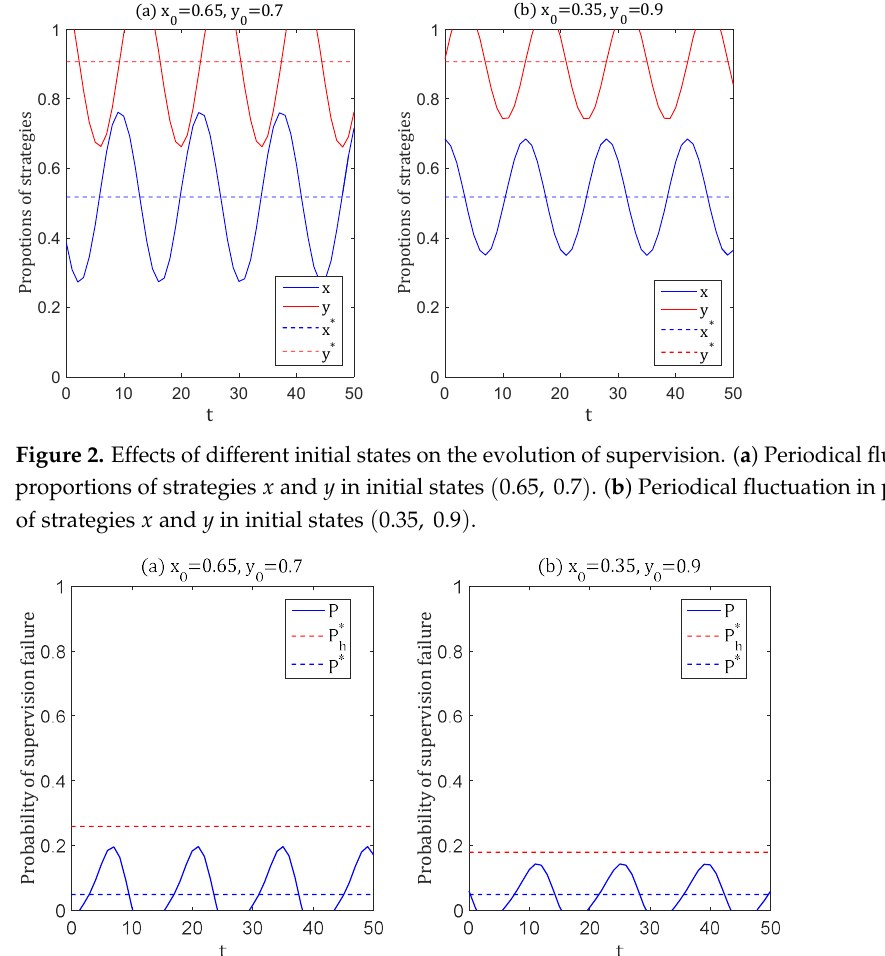
Figure 3. Effects of different initial states on the probability of supervision failure. ( a ) The periodical fluctuation in the probability of supervision failure P in initial state ( 0.65, 0.7 ) , ( b ) The periodical fluctuation in the probability of supervision failure P in initial state ( 0.35, 0.9 ) . The upper limit of the probability of supervision failure (cid:1842) (cid:3035)∗ is also affected by the initial states.